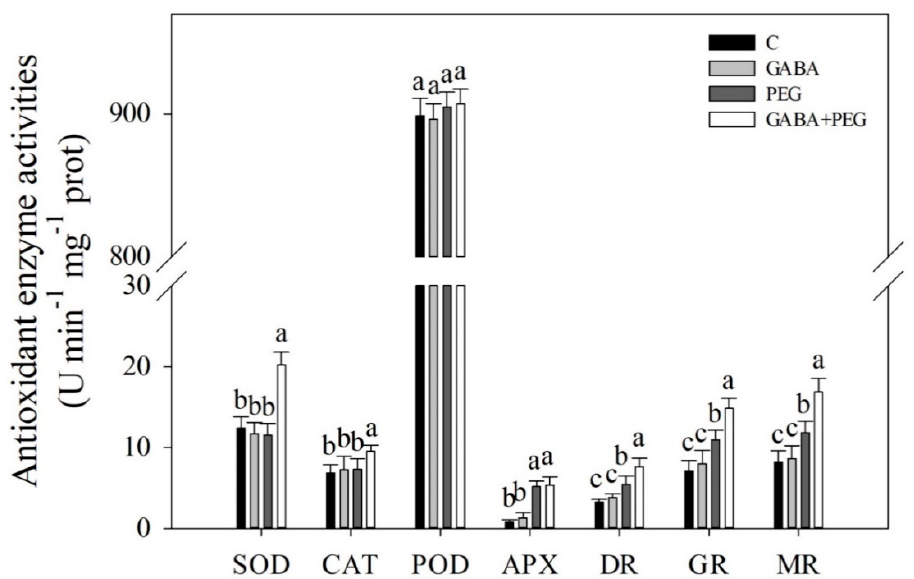
Figure 4. Effects of exogenous γ -aminobutyric acid (GABA) pretreatment on antioxidant enzyme activity in leaves of creeping bentgrass under non-stress and water stress conditions. SOD, superoxide dismutase activity; CAT, catalase activity; POD, guaiacol peroxidase activity; APX, ascorbate peroxidase activity; DR, dehydroascorbate reductase activity; GR, glutathione reductase activity; MR, monodehydroascorbate reductase activity. Vertical bars indicate ± SE of mean ( n = 4). Different letters above columns indicate significant difference based on the LSD ( P ≤ 0.05). C, well-watered control; GABA, well-watered control pretreated with GABA; PEG, PEG-induced water stress; GABA + PEG, water-stressed plants pretreated with GABA.